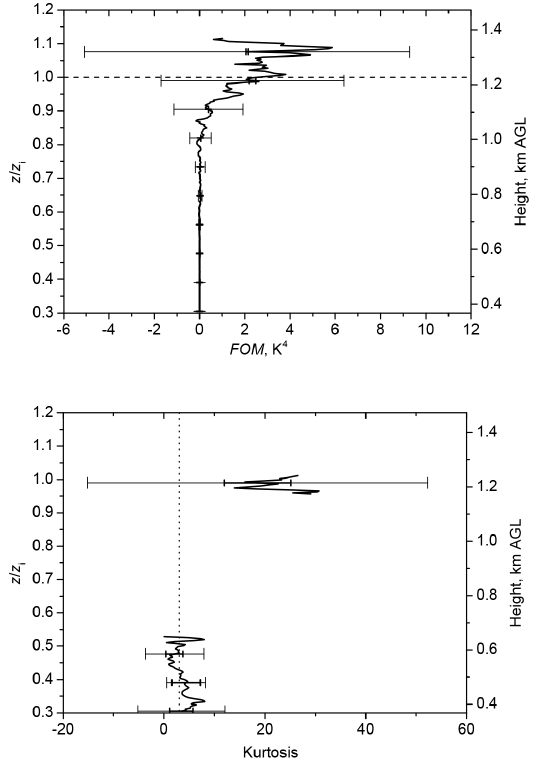
Figure 11. Same as Fig. 9 but profiles of the fourth-order moment (FOM) and kurtosis. Only kurtosis data below 0.55 and around 1.0 z/z i are shown because other data are too noisy. The dotted vertical line in the lower panel marks a value of 3 which is the kurtosis of the normal distribution. Error bars show the noise errors (thin er- ror bars) and the sampling errors (thick error bars). The mean CBL height z i of 1230m (dashed line in the upper panel) was used for the relative height scale z/z i